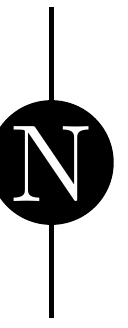
Figure 32. B-Parking, abbrev.